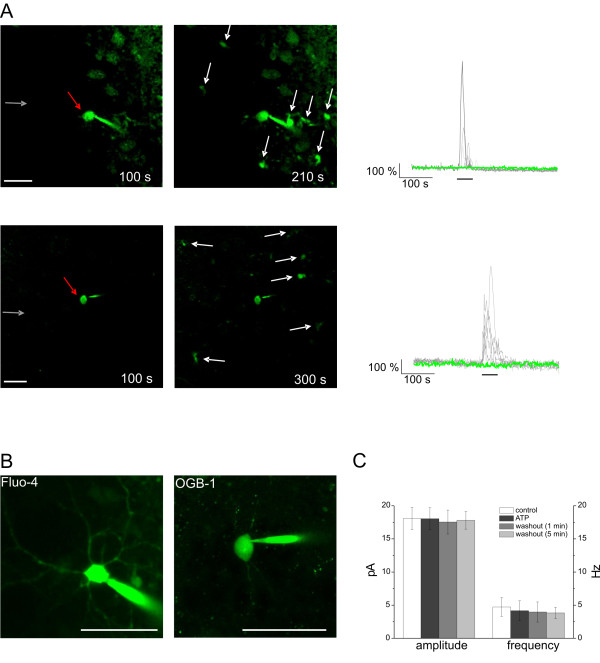
Neuronal activity is not modified by ATP-responsive astroglial Ca2+ signalling in the NAc slice. A: Fluo-4/tetrapotassium (200 μM) (upper image, left; red arrow) or OGB-1/hexapotassium (50 μM) (lower image left; red arrow) salt filled neurons (B left or right images) were distinguished by the presence of the fast Na+ current in the NAc slice. They did not colocalize (A upper and lower images, right; gray arrows indicate the orientation of the long ATP puff) with the long ATP puff-induced Ca2+ transients in NAc astrocytes (white arrows). Representative gray and green (dF/F0)max traces in A show astroglial and neuronal (B) Ca2+ fluorescence, respectively. Scale bar is 50 μm. B: Higher magnification of Fluo-4/tetrapotassium (200 μM) (B left) or OGB-1/hexapotassium (50 μM) (right) filled neurons. Scale bar is 50 μm. C: Summary of the average values of characteristic properties of postsynaptic currents recorded from neurons in the NAc slice. Currents were recorded at -70 mV holding potential using K-Gluconate-based pipette solution. Peak amplitudes and frequencies of individual currents were averaged throughout 1-min intervals. Mann-Whitney test used for statistical evaluation of amplitude and frequency variations, neither of them was found to be significant (18 neurons, 10 slices, 10 rats; p > 0.05).